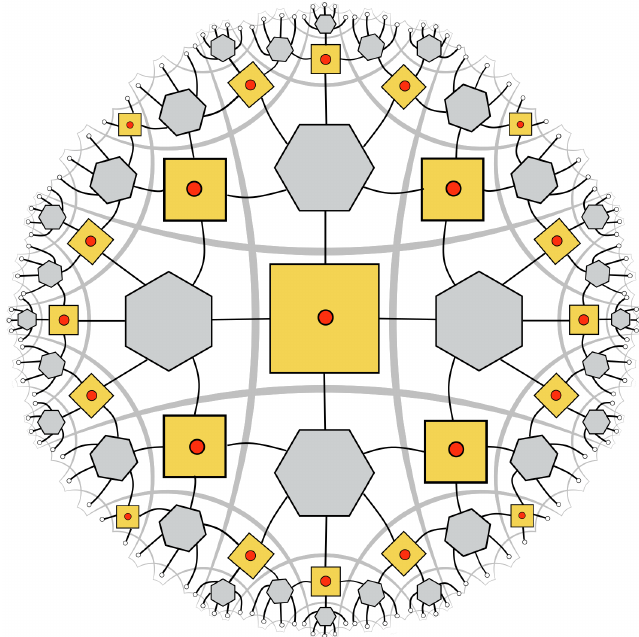
Figure 17. Each square tile is associated with a 4-leg tensor. In the case of a single copy construction, each 4-leg tensor is precisely a Bacon-Shor tensor and a hexagon is a perfect tensor. In the double or multi-copy construction, each 4-leg tensor is replaced by the multi-copy Bacon- Shor code whereas the hexagons are multi-copy perfect tensors. The planar graph G is marked in light